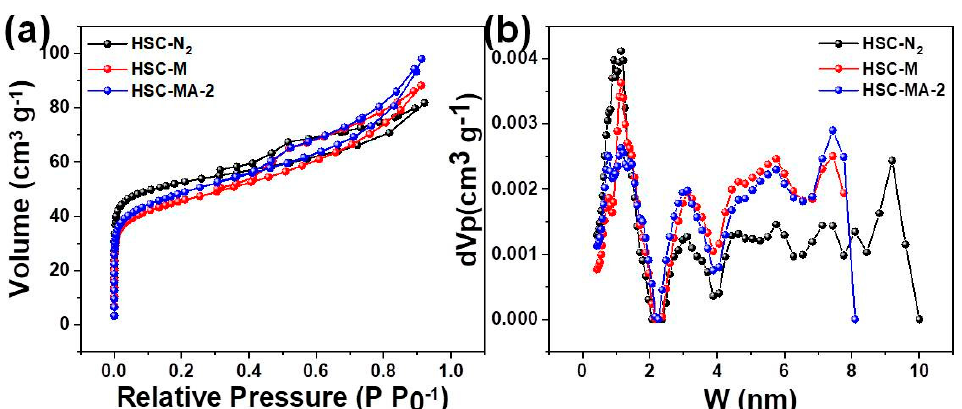
Figure 5. ( a ) Nitrogen adsorption/desorption analysis and the ( b ) pore size distribution of the HSC-N 2 , HSC-M and HSC-MA-2. Table 3. BET surface specific area (SSA) and pore structure of biochars.